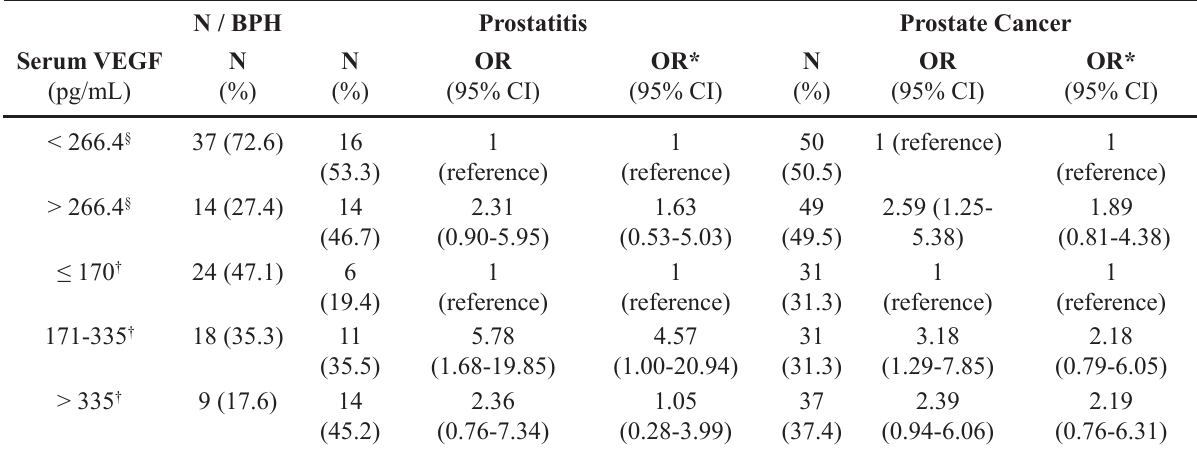
Table 2 – Multivariate logistic analysis of the association between vascular endothelial growth factor (VEGF) and prostate histology.